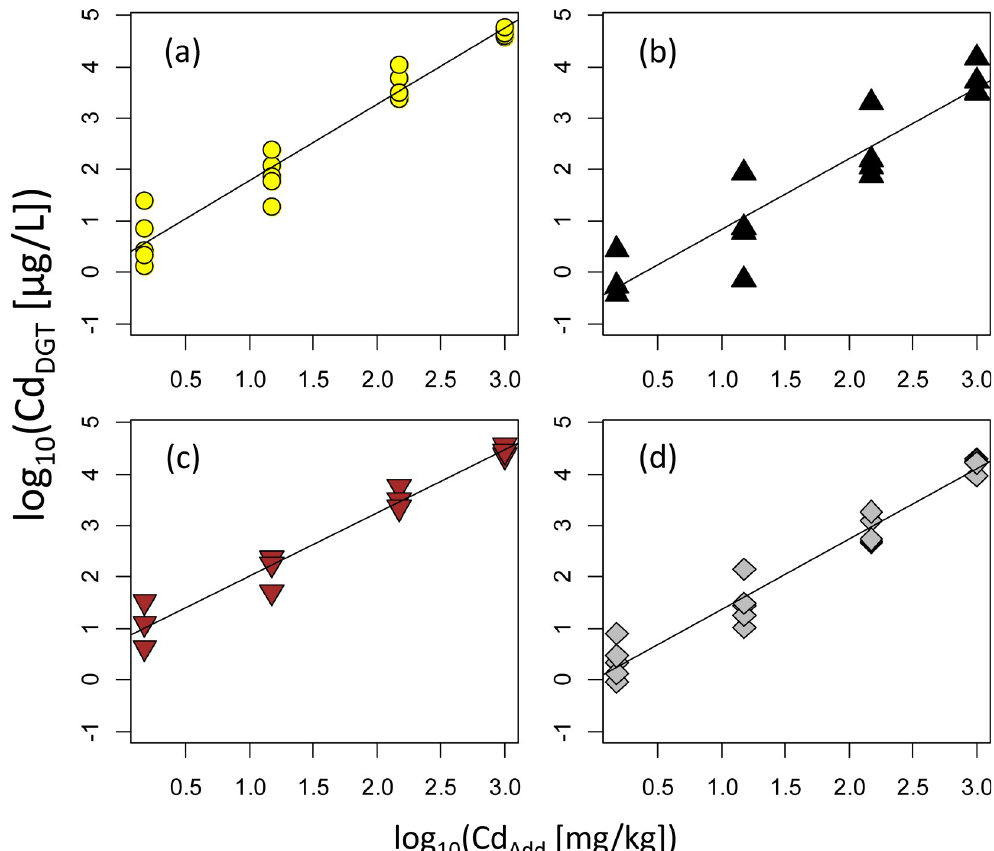
Fig 1. Relationship between [Cd Add ] and [Cd DGT ] for (a) sandy soils, (b) andosols, (c) brown forest soils, and (d) cohesive